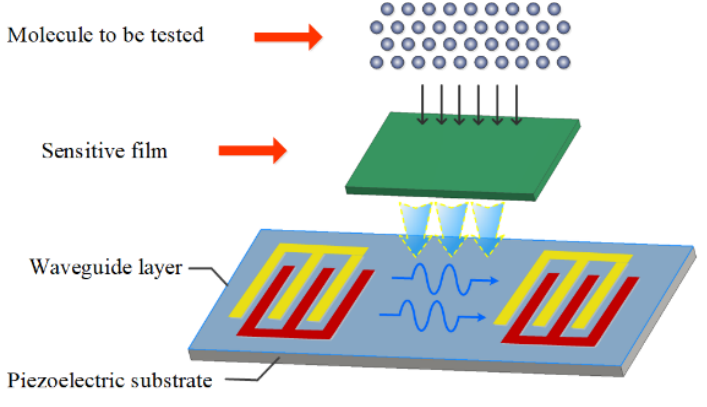
Figure 1. Schematic diagram of the Love wave mode sensor.